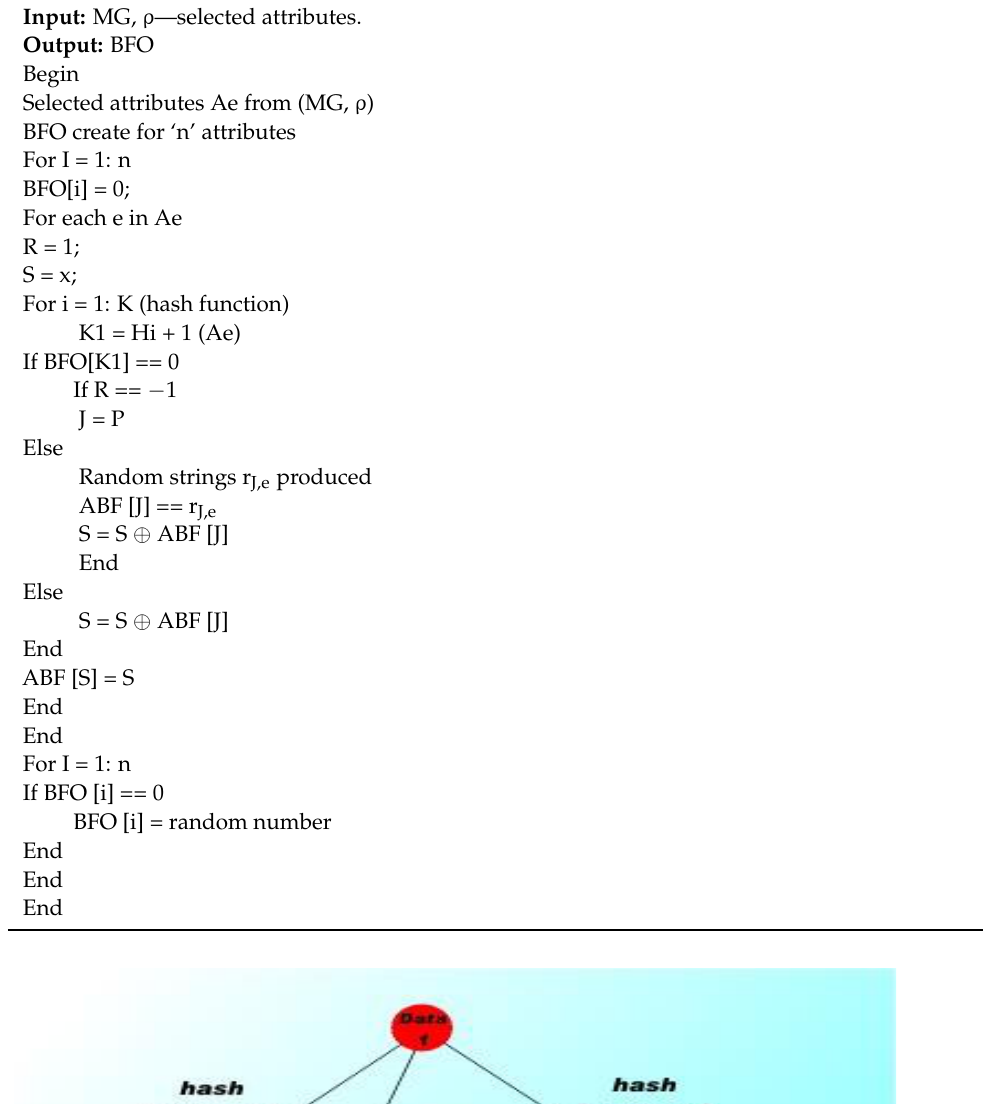
Algorithm 2: Selected Attributes Using BF